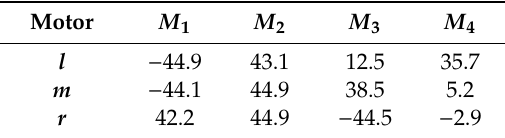
Table 3. Rotation angle of each individual Figure 13. Snaky movement trajectories.